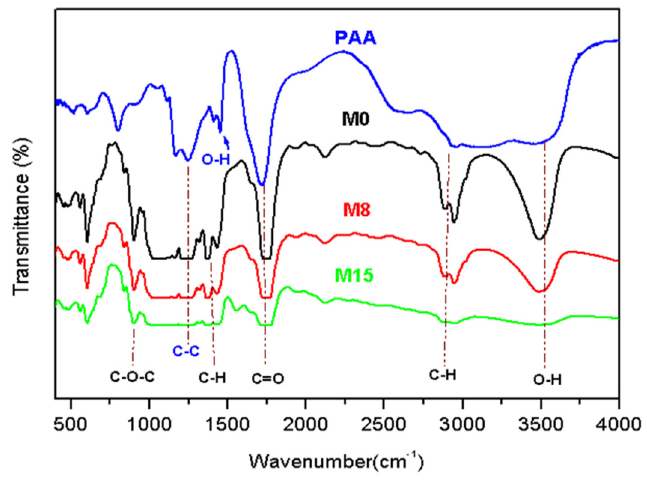
Figure 1. FTIR spectra of pure CA membranes (M0) and CA/PAA blend membranes (M8 and M15).